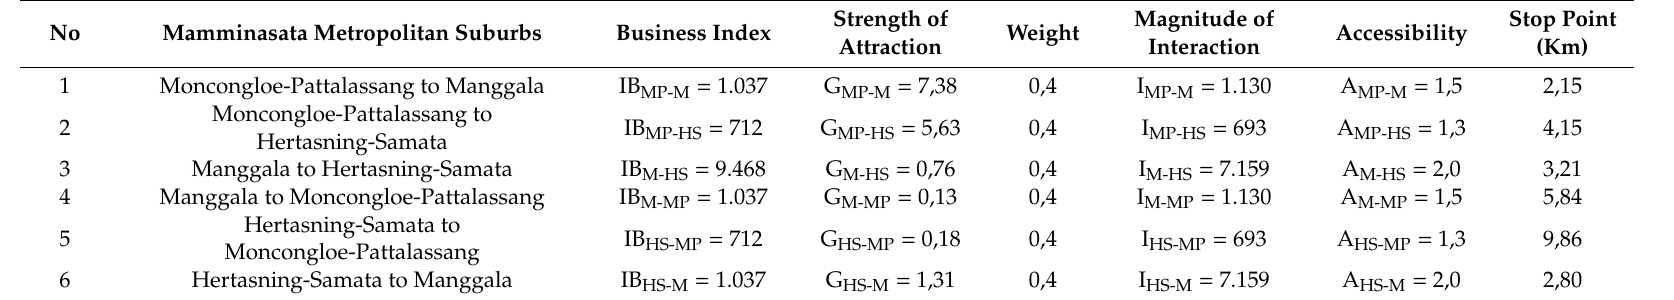
Table 4. Mamminasata Metropolitan Suburban Spatial